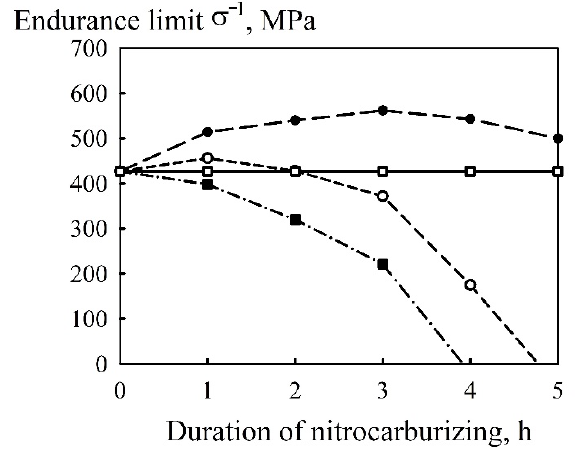
Figure 7. The dependencies of the endurance limit for nitrocarburized steel 60Si2Cr on the duration of nitrocarburizing at di ff erent temperatures: ● —550 °C; ○ —600 °C; ■ —650 ° С ; □ —without harden- tion of nitrocarburizing at different temperatures: • —550 ◦ C; ing treatment. hardening